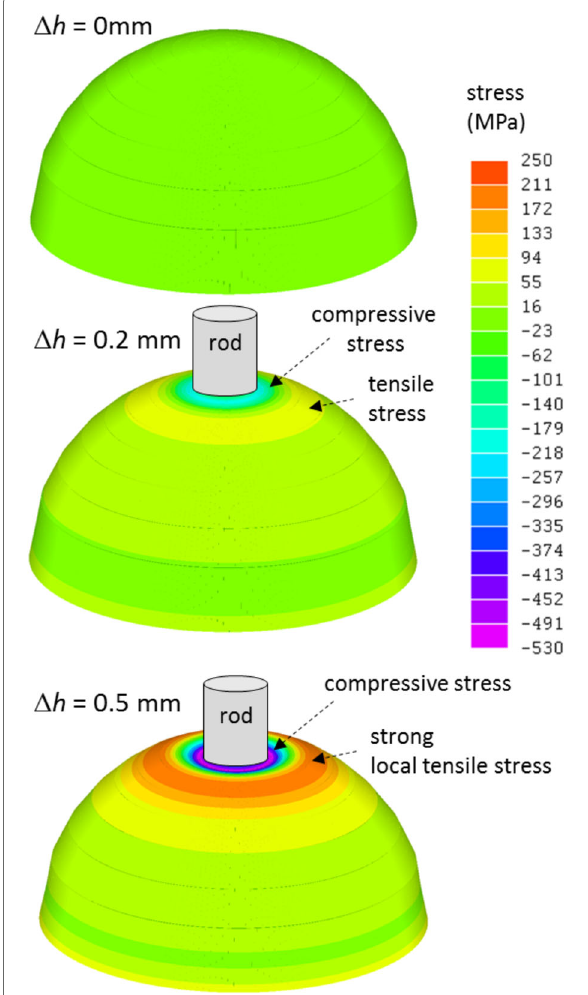
Fig. 6 Calculated principal stress distribution on the modeled thin PEN hemisphere face calculated using finite element method. With increasing (cid:2) h , compressive stress arises within and near the contact area, and strong local tensile stress arises in the periphery of the contact area